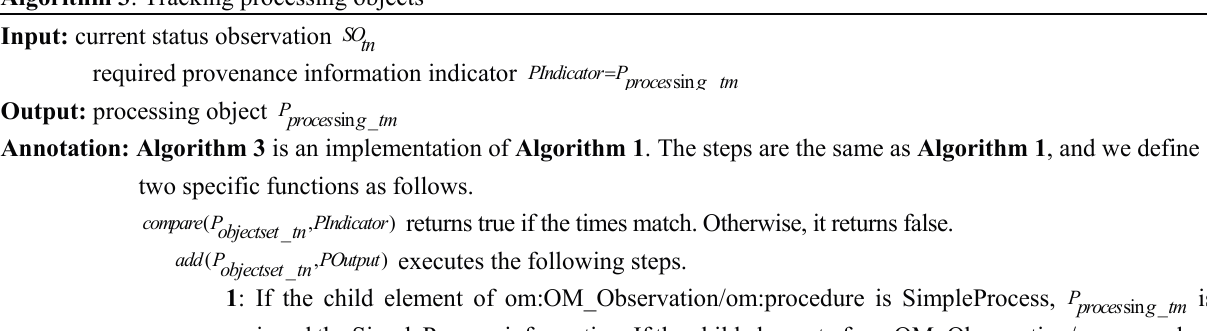
Algorithm 3 : Tracking processing objects